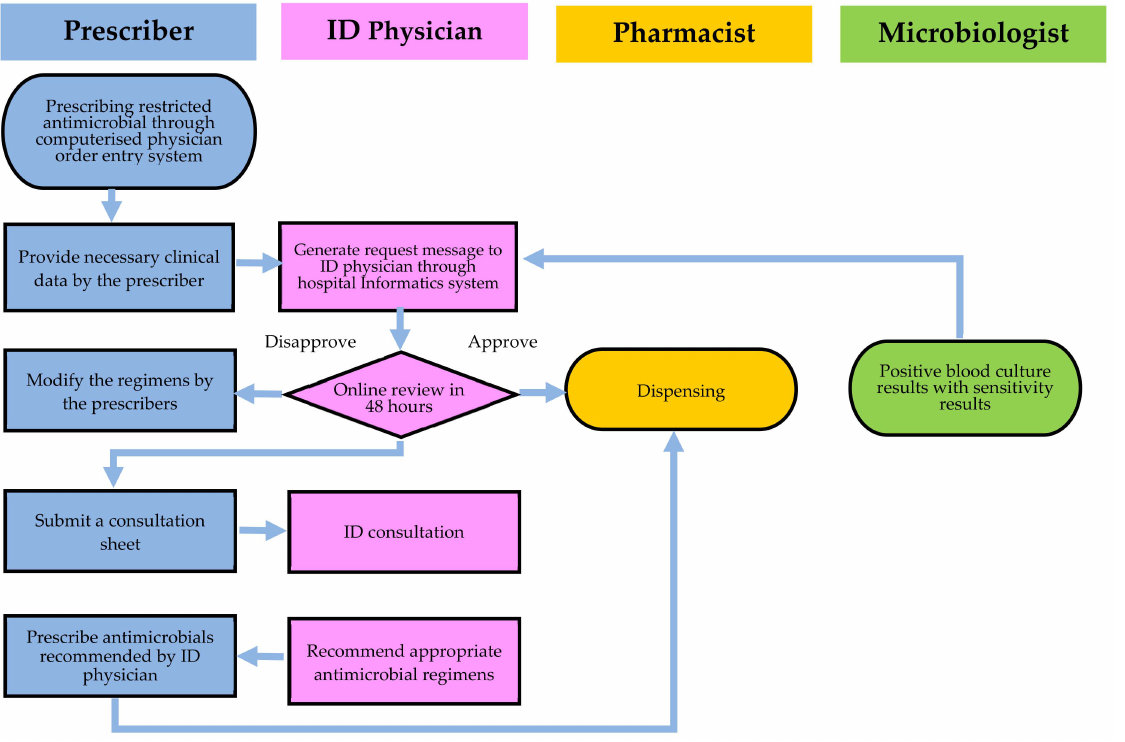
Figure 2. An overview of the hospital-wide computerized antimicrobial approval system (HCAAS). Infectious diseases (ID) physicians have three options following online review of the antimicrobial prescription: approval, disapproval, or an on-site